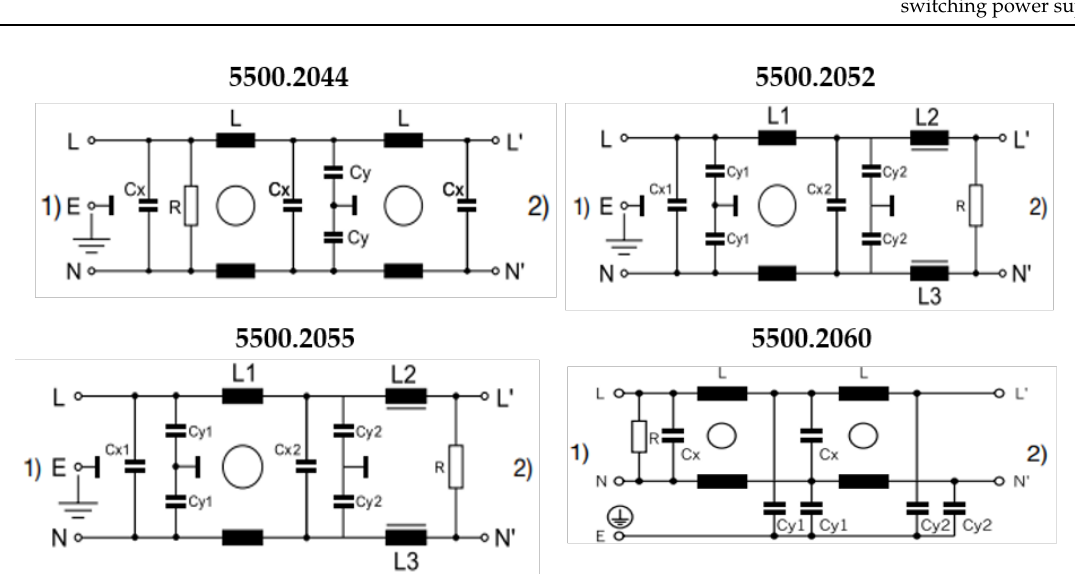
Figure 2. Schematics of the four EMC filters—5500.2044 ( upper left ), 5500.2052 ( upper right ), 5500.2055 ( bottom left ), 5500.2060 ( bottom right ) [16]. Table 2. Components of the four EMC filters [16].